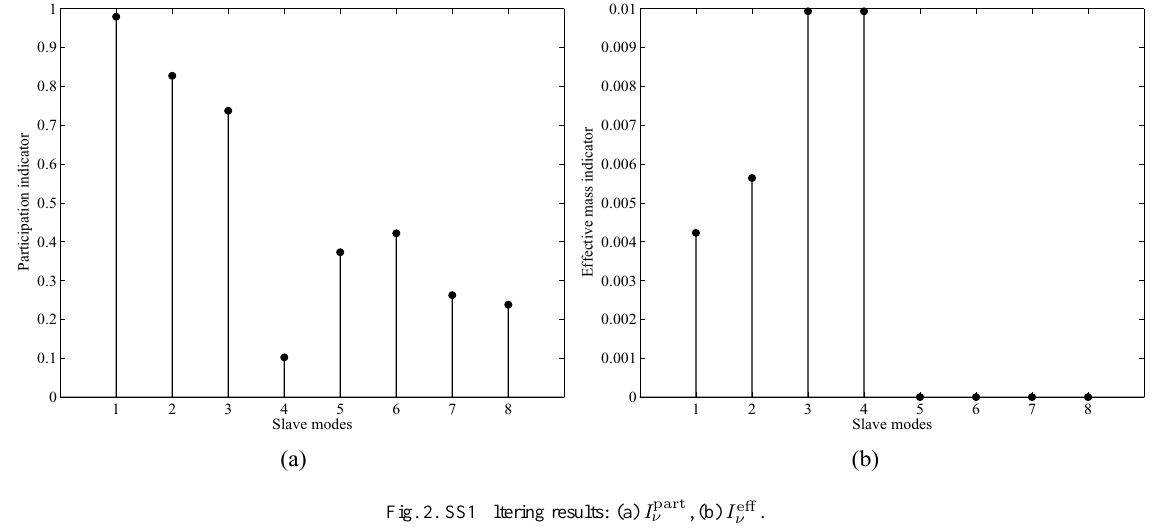
Fig. 2. SS1 filtering results: (a) I part ν , (b) I eff ν .